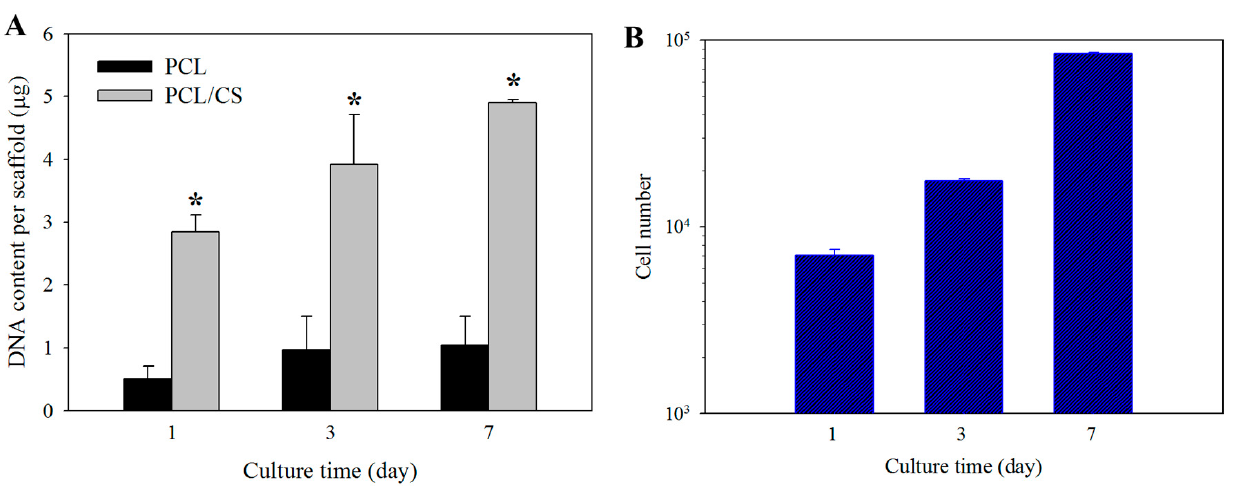
Figure 5. ( A ) Proliferation of mesothelial cells in PCL and PCL/CS nanofiber membranes from DNA assays. * p < 0.05 compared with PCL. ( B ) Proliferation of mesothelial cells on a petri dish from cell counting.